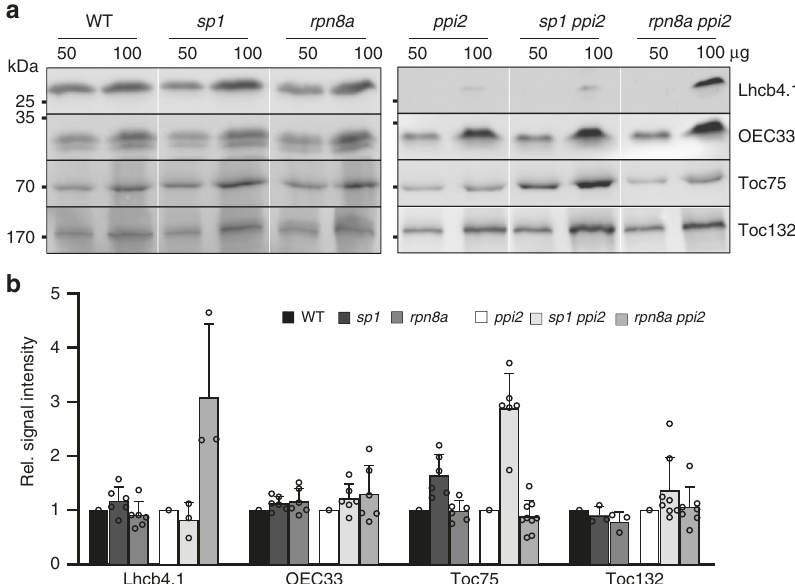
Fig. 4 Determination of protein abundance in the indicated plant lines. a Immunoblotting with antibodies against Lhcb4, OEC33, Toc75, and Toc132 with 50 and 100 µ g plant extracts. b Quantitative determination of the indicated proteins from western blot analyses. Data are derived from at least three biological replicates. Genotypes tested were wildtype (WT), sp1, rpn8a, ppi2 single mutants and sp1 ppi2 and rpn8a ppi2 double mutants. The membrane was decorated with antibodies against the indicated proteins and the intensity was determined by Image J after normalization against the amido-black stain of the membrane. Error-bars represent SD. Note that the number of data points provided for the Lhcb4 antibody is three as opposed to six for the other antibodies. This is because no Lhcb4 signal was detected in several replicates with ppi2 , so that a relative signal intensity could not be